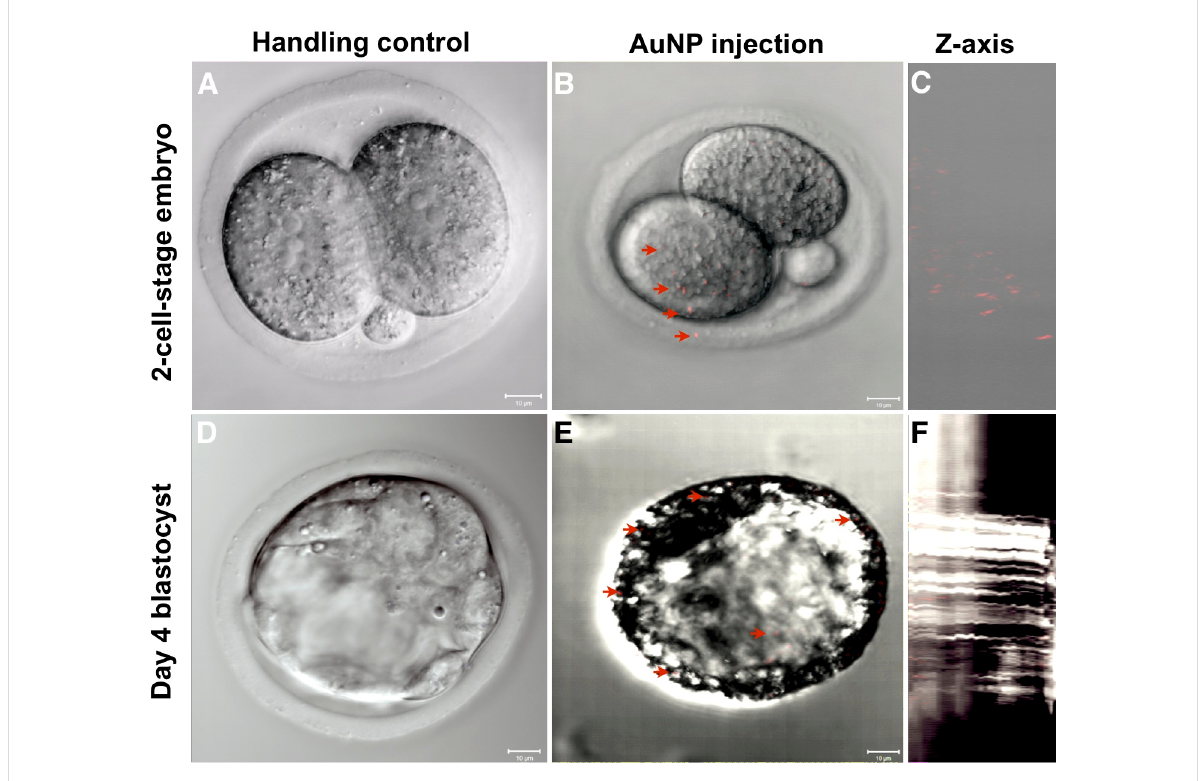
Figure 2: Representative laser scanning microscope images of murine embryos (projections of 10 optical sections (1 µm each)) after the injection of gold nanoparticles (10 pL of a 50 µg/mL nanoparticle dispersion, equal to 1000 nanoparticles/embryo, mean primary particle diameter as determined by TEM: 11 nm). An overlay of the differential interference contrast (DIC) merged with the gold nanoparticle detection channel is shown. Upper panels – Two-cell-stage embryos: (A) handling control, (B) embryo shortly after AuNP injection, one nanoparticle is located in the zona pellucida, highlighting the injection canal, (C) z-axis of projection (B); Lower panels – Day-four-blastocysts: (D) handling control, (E) 3 days after AuNP injection, (F) z-axis of (E). AuNP appear in red, some of which are exemplarily pointed out with